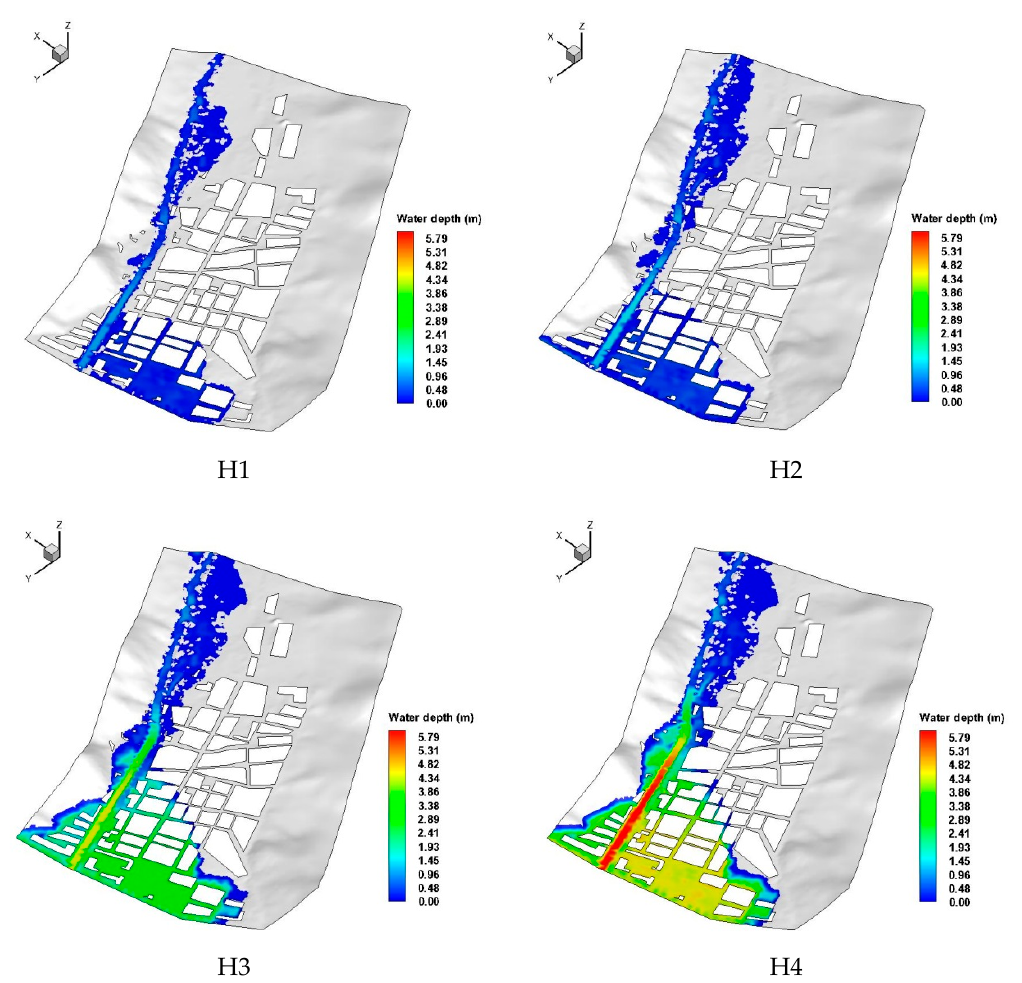
Figure 12. Spatial distribution of the inundated water depth in the four scenarios of the flood inflow rate.